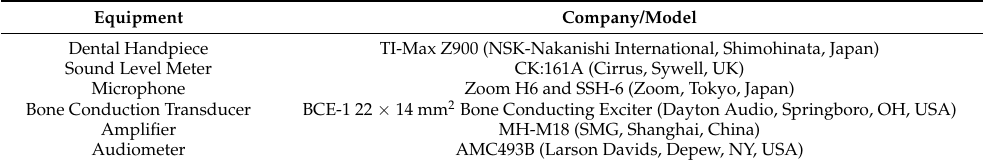
Table 1. Equipment used for dental handpiece noise level measurement and analysis.